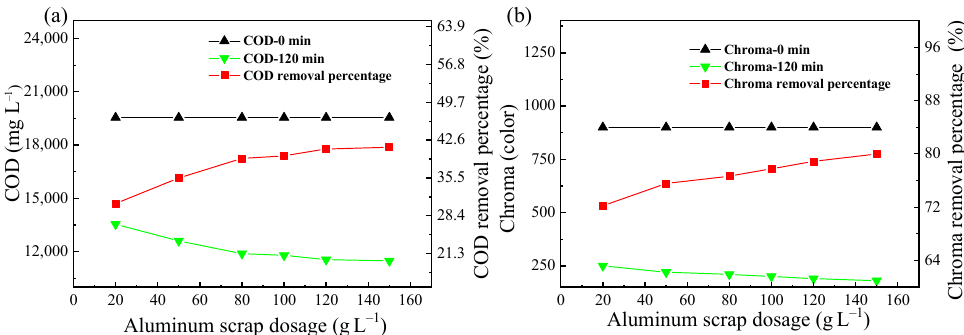
Figure 2. Influence of Al scrap dosage on ( a ) COD and ( b ) chroma removal at 2 h. Reaction conditions: Activated carbon dosage, 200 g L − 1 ; rotation speed, 150 r min − 1 ; pH value, 10.